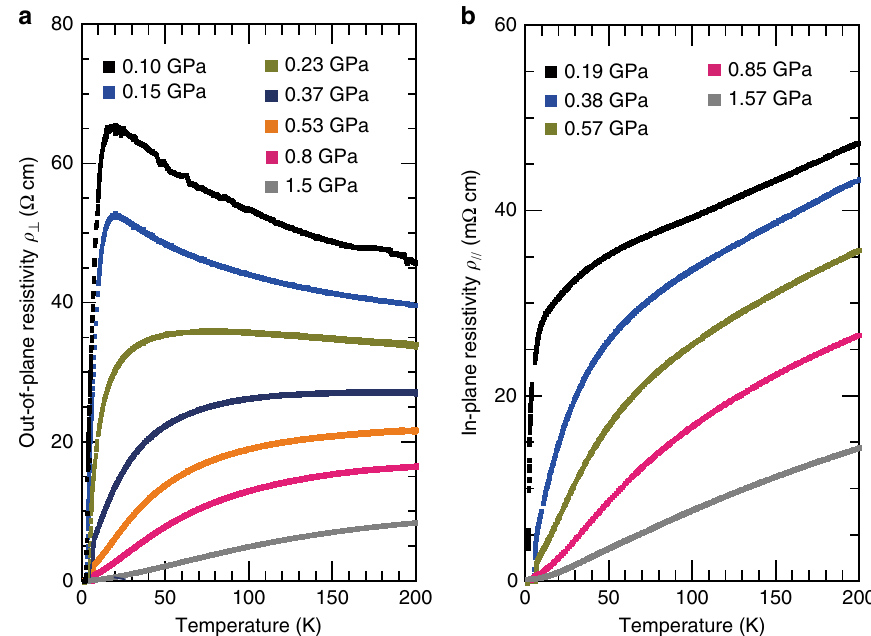
Fig. 3 Out-of-plane and in-plane resistivities of κ -(ET) 4 Hg 2.89 Br 8 . a , b Temperature dependences of out-of-plane resistivity ρ ⊥ ( a ) and in-plane resistivity ρ // ( b ) at several pressures. At ambient pressure, this material shows a number of spurious jumps in resistivity with temperature variation, very probably due to micro-cracking in the crystal, as encountered in several organic materials. Thus, applying fi nite pressures was necessary for obtaining reliable data